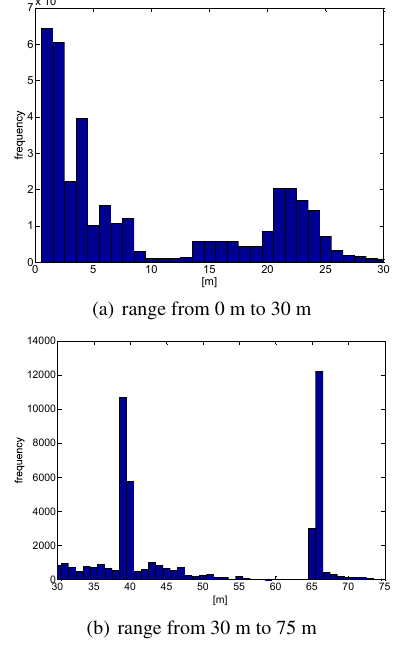
Figure 4: Histogram of distance values (raw